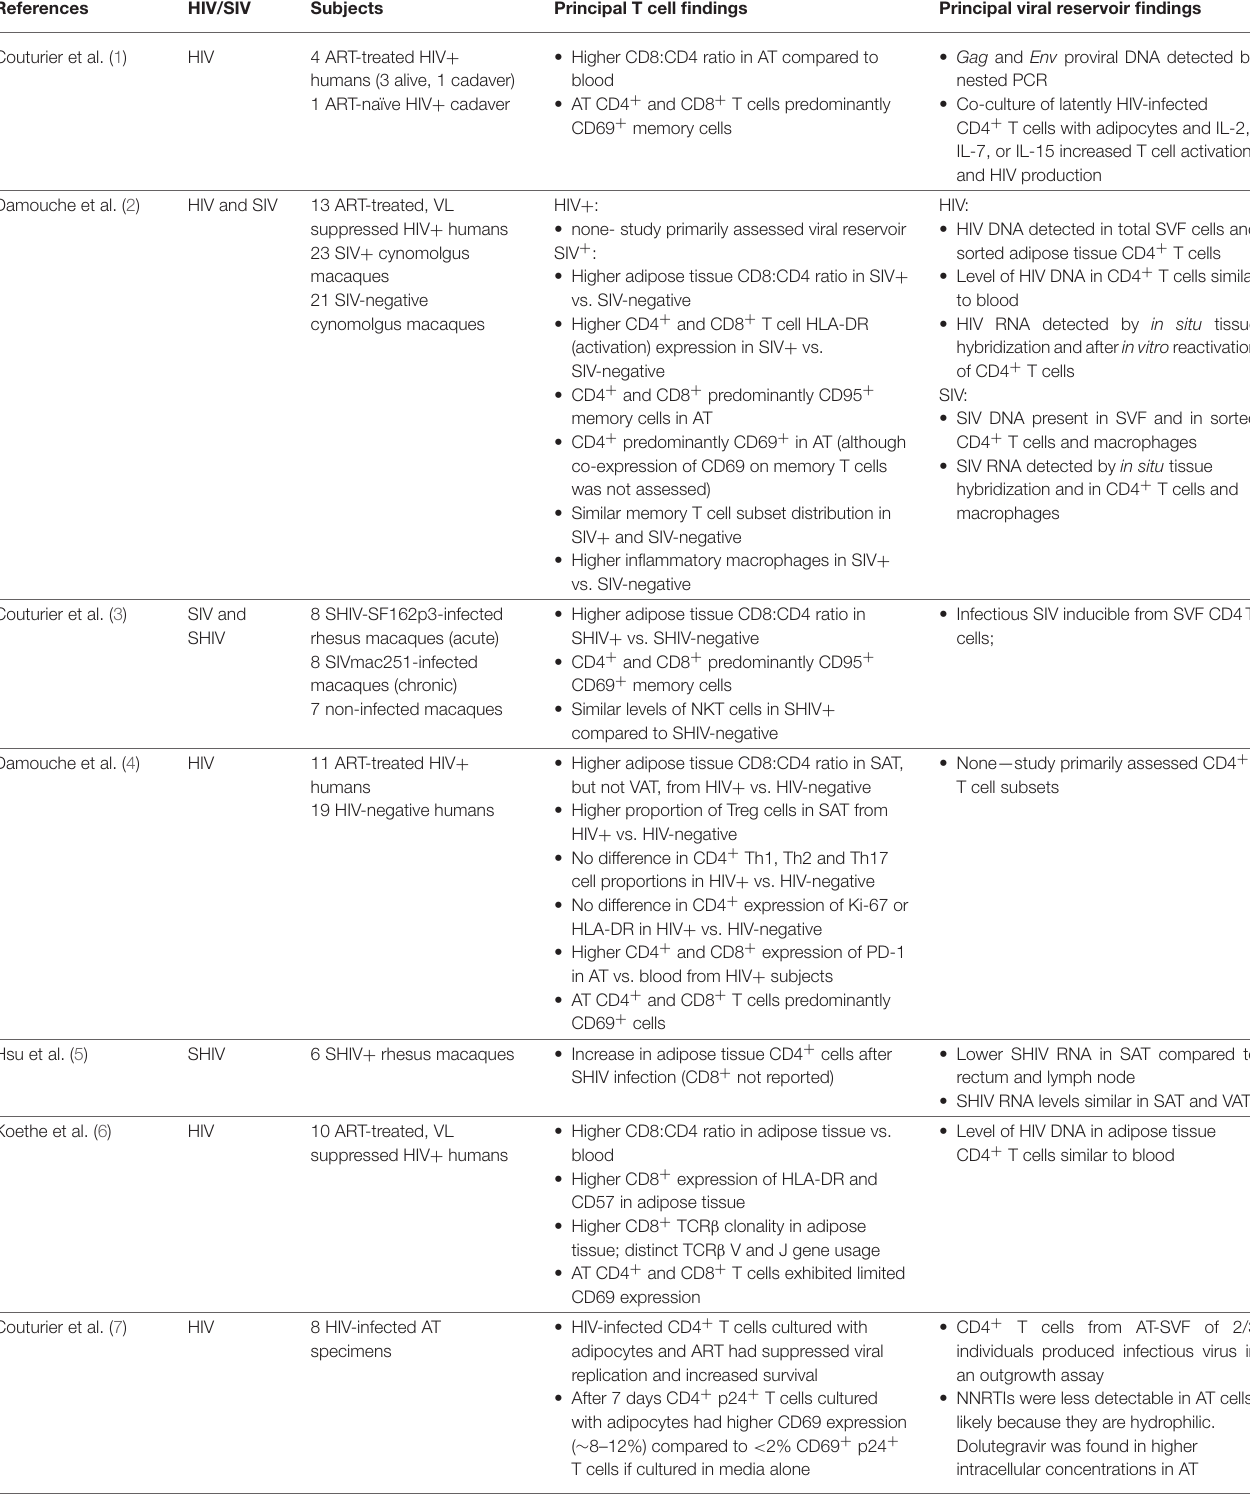
TABLE 1 | Summary of studies on adipose tissue T cells and the viral reservoir in HIV and